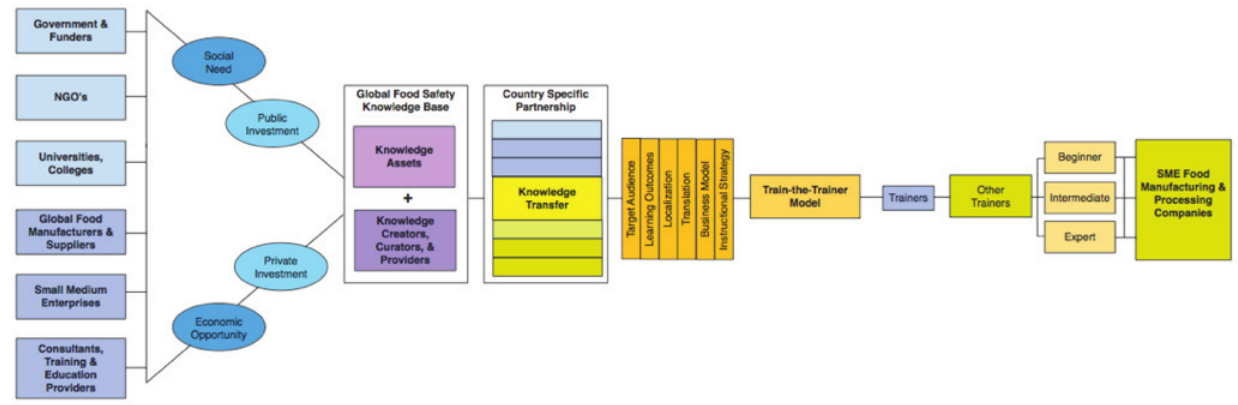
Figure 2. Case Eexample of China. This figure provides an overview of collaborators, resources and approaches being implemented in